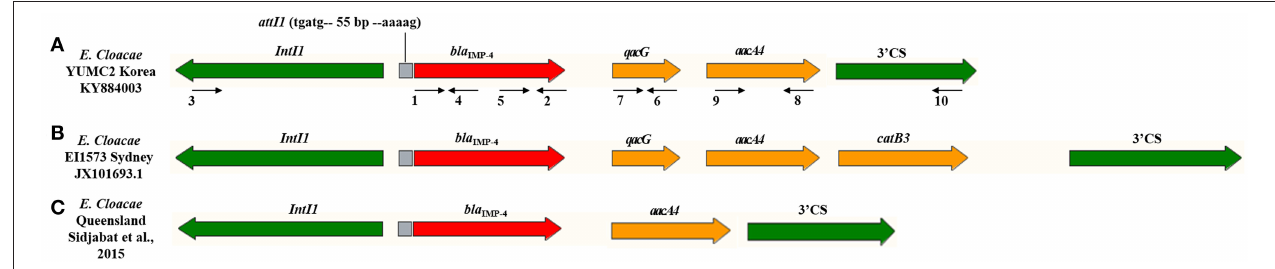
FIGURE 2 | Schematic representation of the class 1 integron gene cassettes bearing the bla IMP - 4 genes in E. cloacae isolates . Genes and their directions of transcription are described as broad arrows. The gray box indicates recombination site. The primers, detailed in Table 1 , for PCR mapping are depicted as narrow arrows with numbers. The red arrow of bla IMP - 4 is related to carbapenemase. The yellow arrow of qacG and aacA4 are associated with resistance to quaternary ammonium compounds and fluoroquinolone, respectively. The 5 ′ conserved segment (CS) of IntI1 and 3 ′ CS of sul1 are presented with green arrow. (A) E. cloacae YUMC2 in this study with Genbank accession no. KY884003. (B) E. cloacae EI1573 from Sydney, Australia with Genbank accession no. JX101693.1. (C) E. cloacae from Queensland, Australia reported by Sidjabat et al.